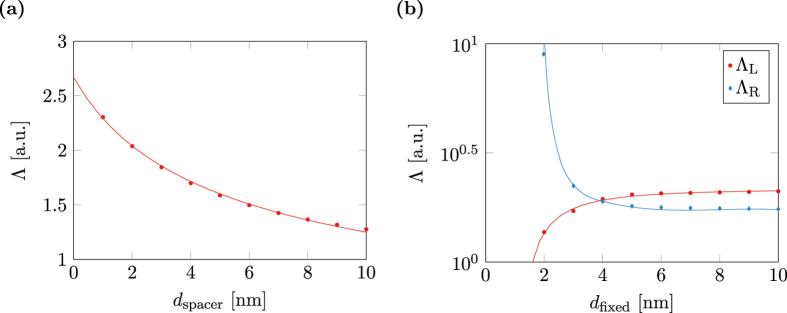
Dependence of the fitting parameter Λ on the geometry of a multi-layer structure with layer thicknesses (5, 2, 3, 2, 5) nm.(a) Variation of the spacer thickness, i.e. (5, 2, dspacer, 2, 5) nm. (b) Variation of the fixed-layer thickness, i.e. (5, dfixed, 3, 2, 5) nm.